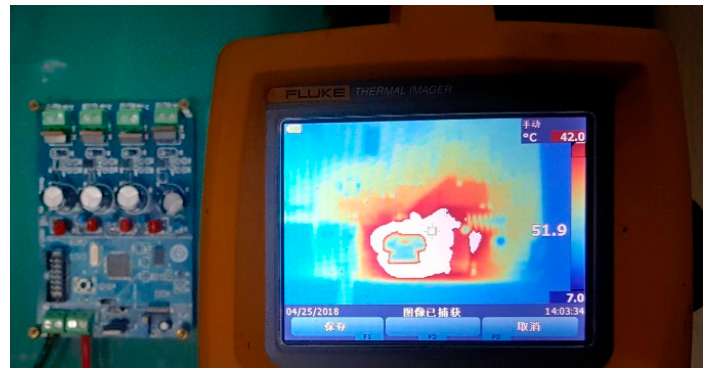
Figure 21. Temperature measurement result of the BU.